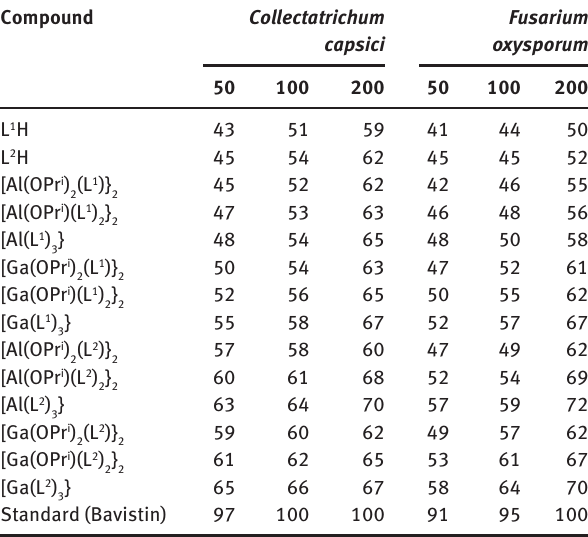
Table 5 Fugicidal screening data for the ligands and their complexes [inhibition after 96 h (%) (conc. in